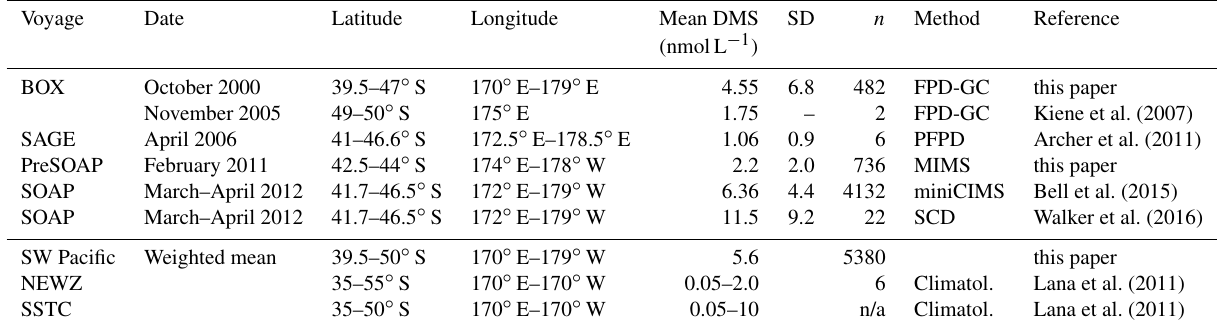
Table 3. DMS data for the SW Pacific region east of New Zealand. SD: standard deviation; n : number of measurements; FPD-GC: flame photometric detector – gas chromatograph; PFPD – pulsed flame photometric detector – gas chromatograph; MIMS – membrane inlet mass spectrometer; miniCIMS – atmospheric pressure chemical ionization mass spectrometer; SCD – sulfur chemiluminescent detector;